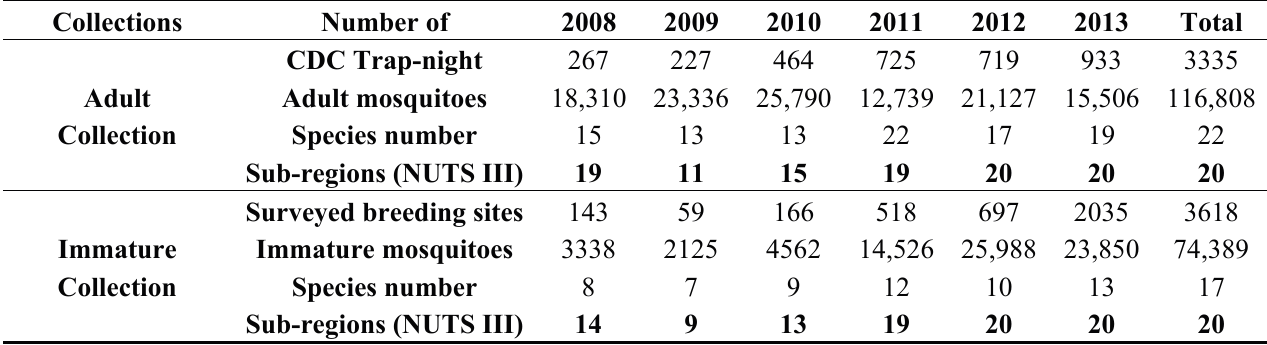
Table 1. Summary of collections in the frame of REVIVE.